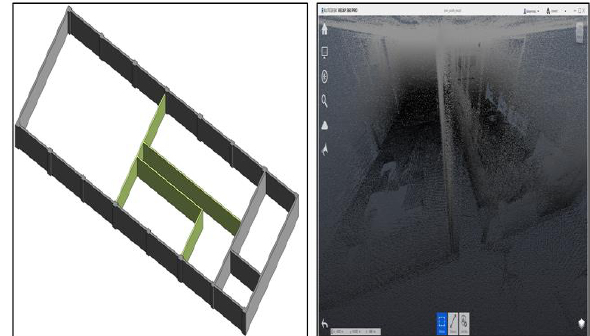
Figure 20. 3D model from MLS